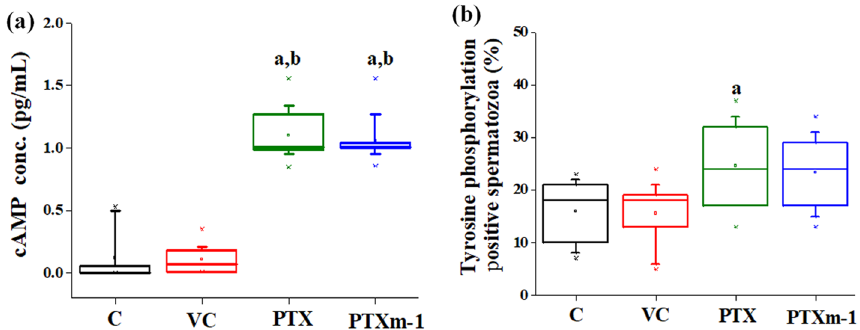
Figure 8. Effect of PTX and PTXm-1 on intracellular cAMP and protein tyrosine phosphorylation levels. ( a ) The box and whisker plot represents median percentage of intracellular cAMP concentration in spermatozoa (N = 8). The error bar represents standard error to mean. a: P < 0.001 compared to control; b: P < 0.001 compared to vehicle control. ( b ) The box and whisker plot represents median percentage of spermatozoa that underwent protein tyrosine phosphorylation (N = 8). The error bar represents standard error to mean. a: P < 0.05, b: P < 0.01 compared to control; c: P < 0.05, d: P < 0.01 compared to vehicle control. C: control; VC: vehicle control; PTX: pentoxifylline; PTXm-1: modified pentoxifylline.